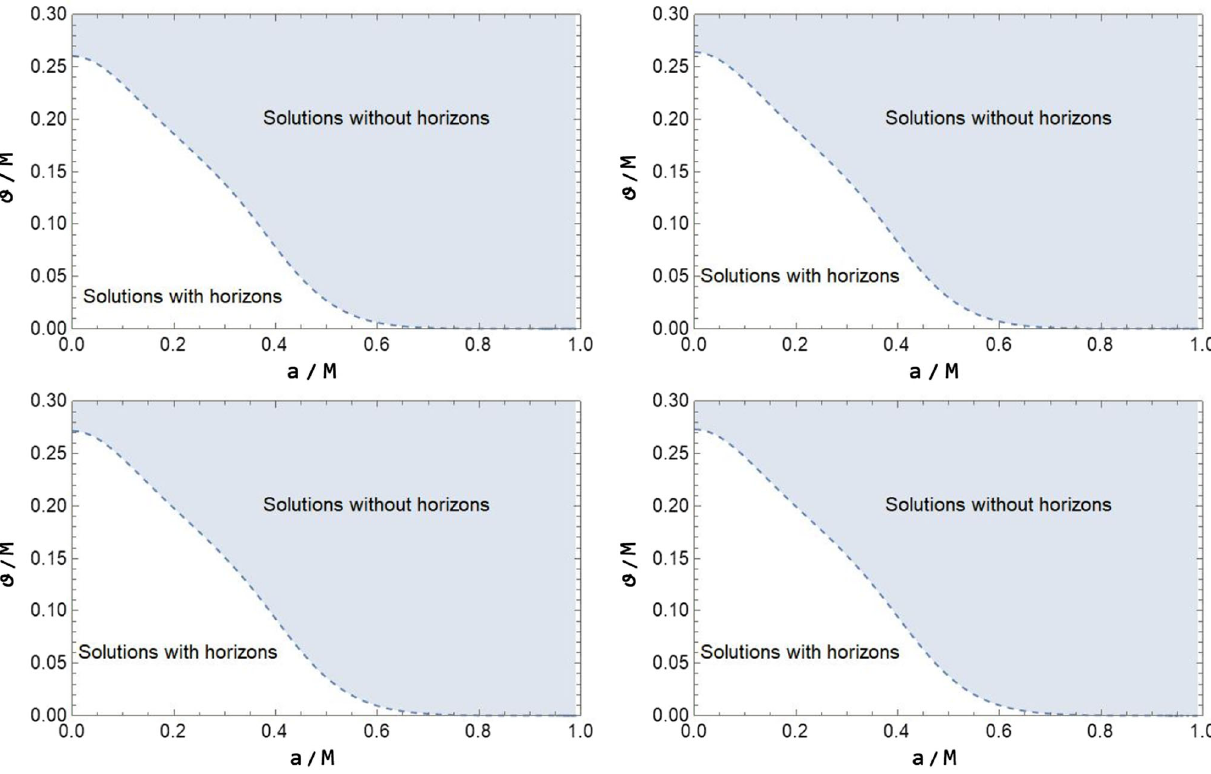
Fig. 1 The plots demonstrating the parameter space for the NC rotating Hayward BH. The upper panel corresponding to g = 1 (left), g = 1 . 1 (right) while the lower panel represents g = 1 . 3 (left), g = 1 . 4 (right). The dotted blue line is the borderline separating the BH region from